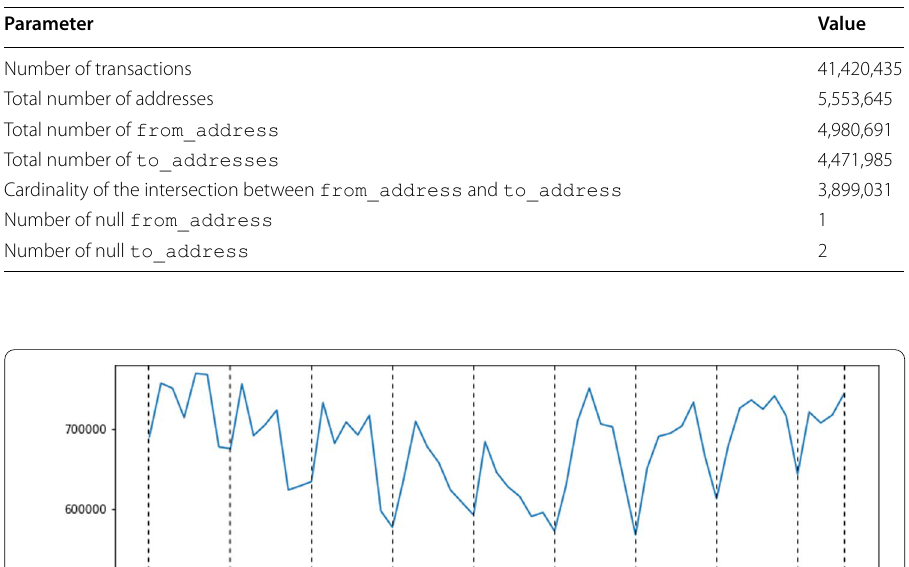
Table 1 Some preliminary statistics performed on our dataset